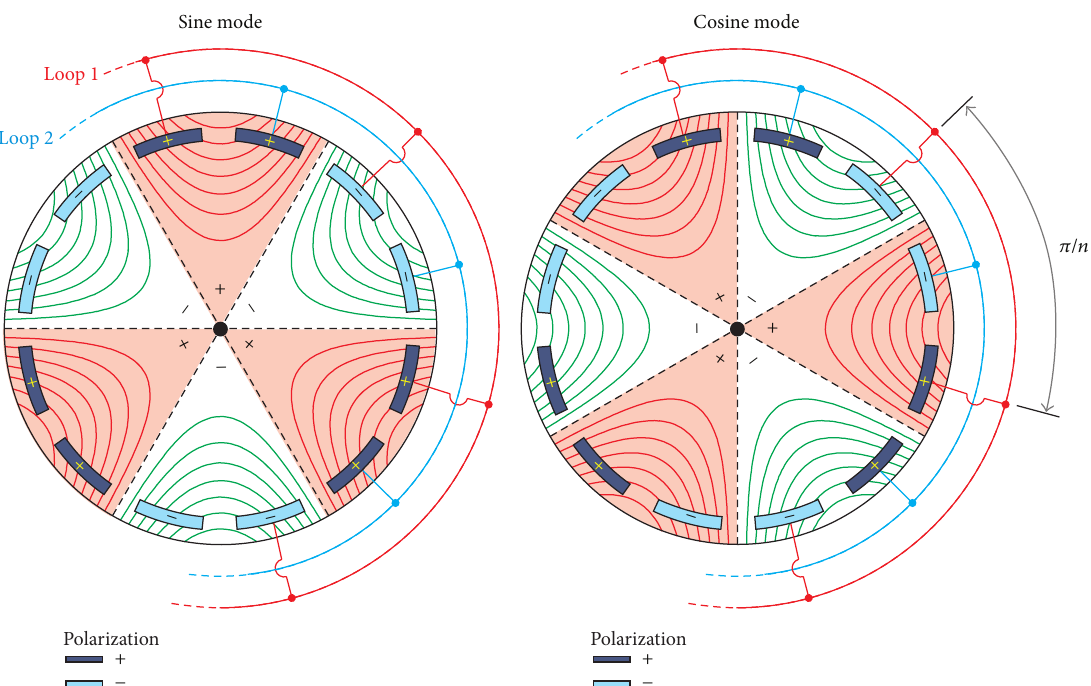
Figure 5: Parallel loop implementation of the shunt damping: electrical connections and polarization diagram illustrated for a mode with 𝑛 = 3 nodal diameters of natural frequency 𝜔 𝑖 . Sine mode and cosine mode. The color on the disk indicates the sign of the curvature and the color of the patches indicates the